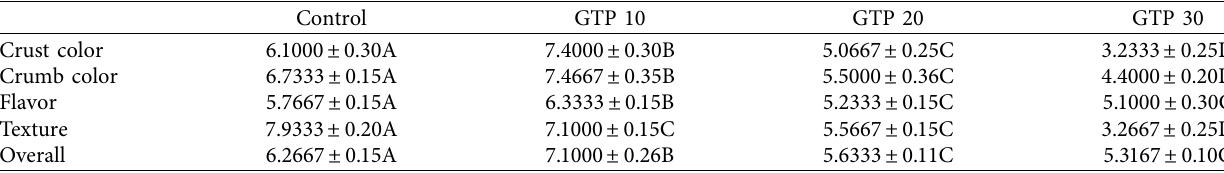
Table 6: Sensory evaluation of various sponge cake samples.